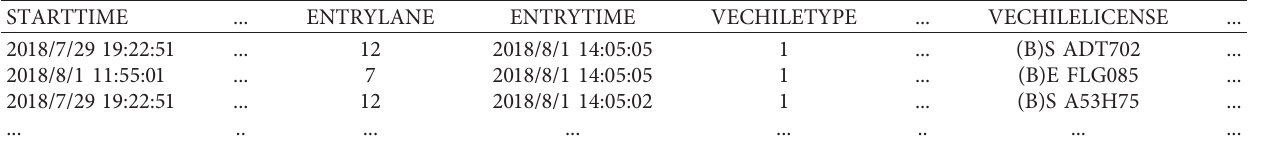
Figure 1: Data preprocessing. Table 1: Partial data of a toll station in Shaanxi Province.